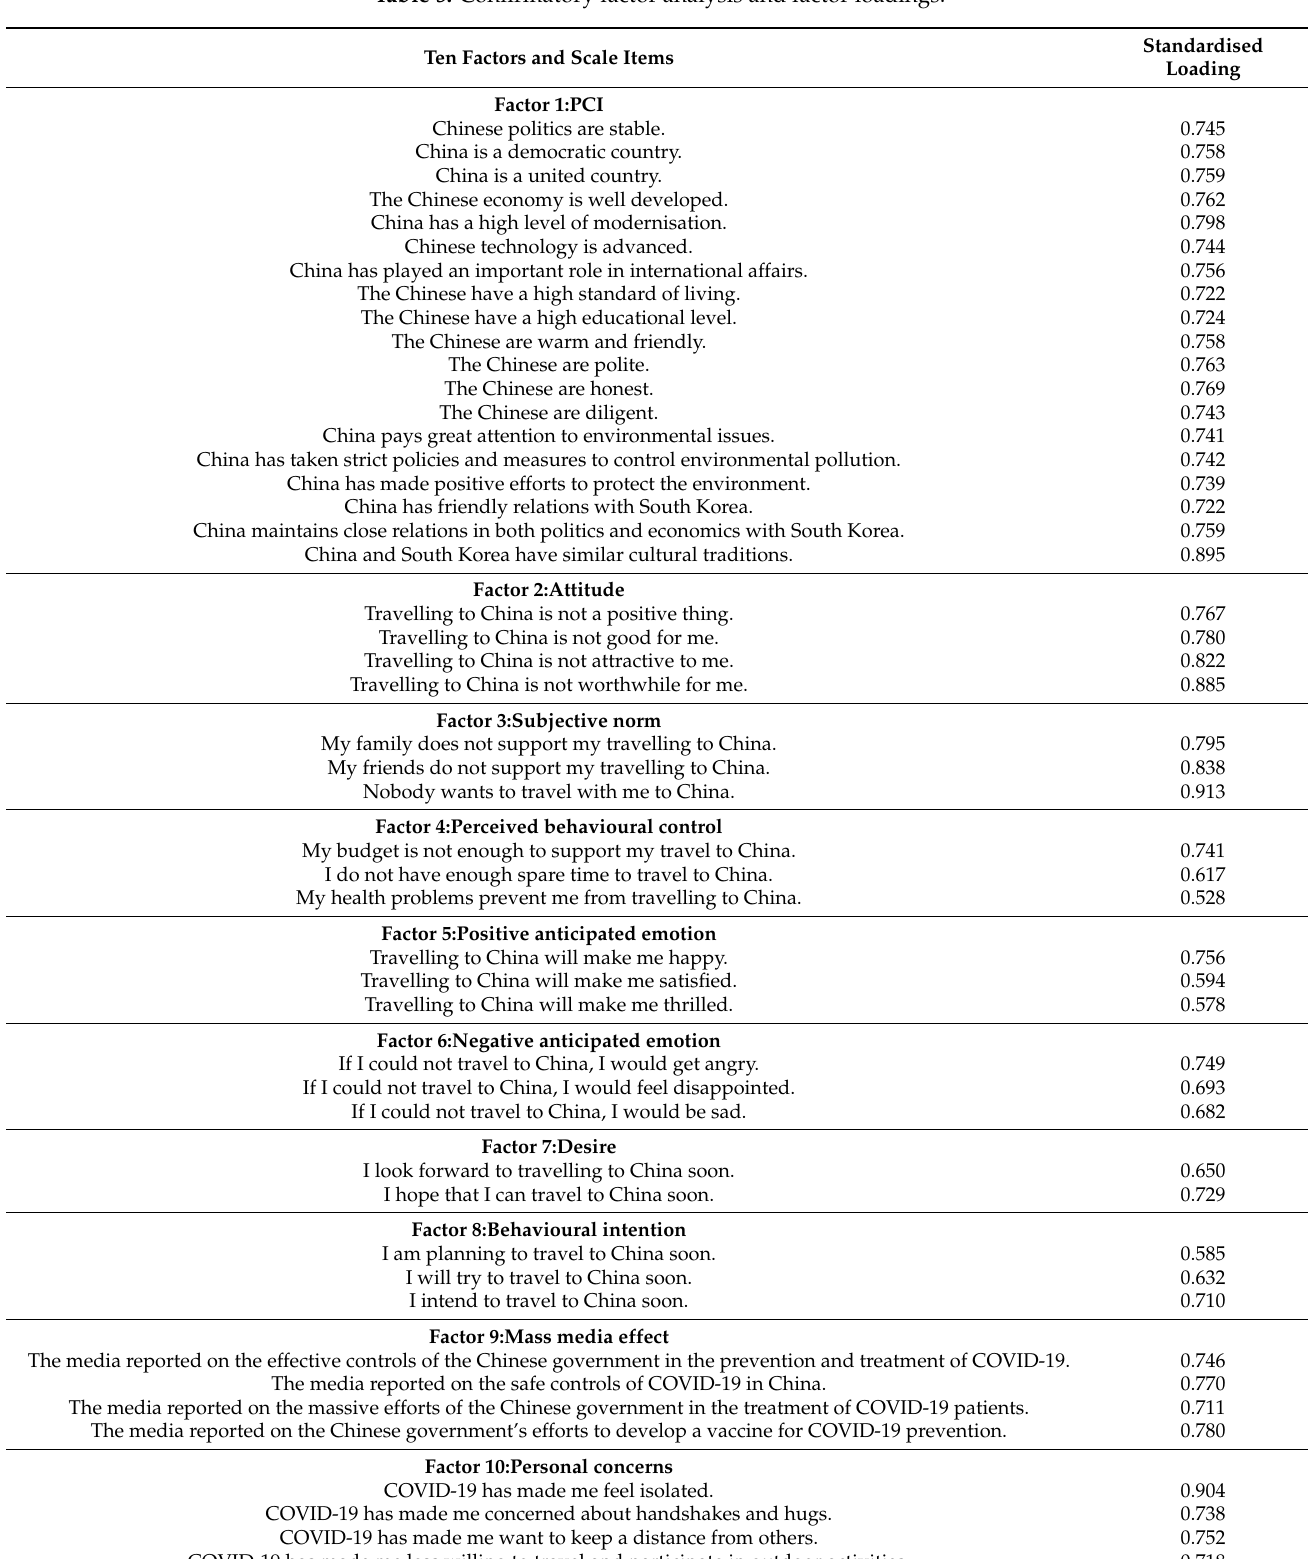
Table 5. Confirmatory factor analysis and factor